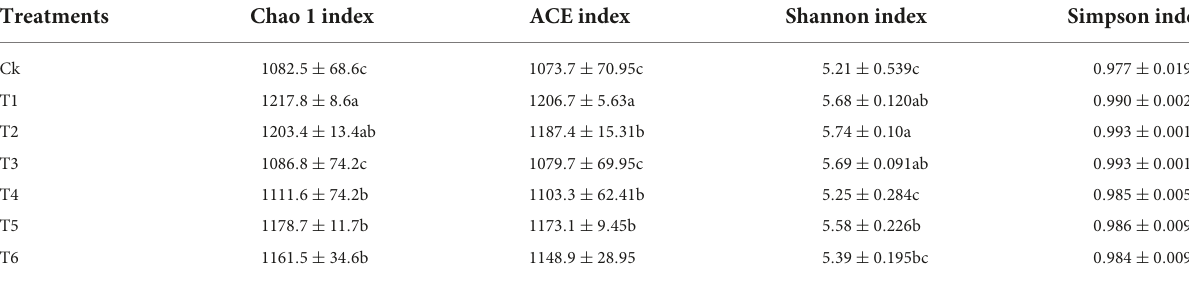
TABLE 2 Alpha diversity index of soil microbial community in pomelo orchard treated with biochar. Treatments